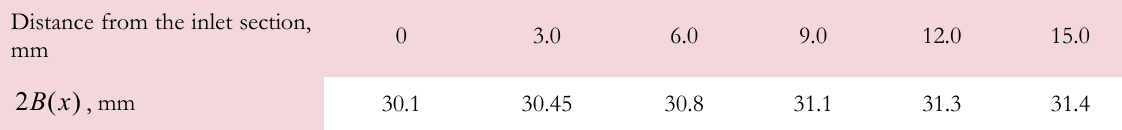
Table 2: Measuring the width of the sample in the deformation zone (experiment 1).